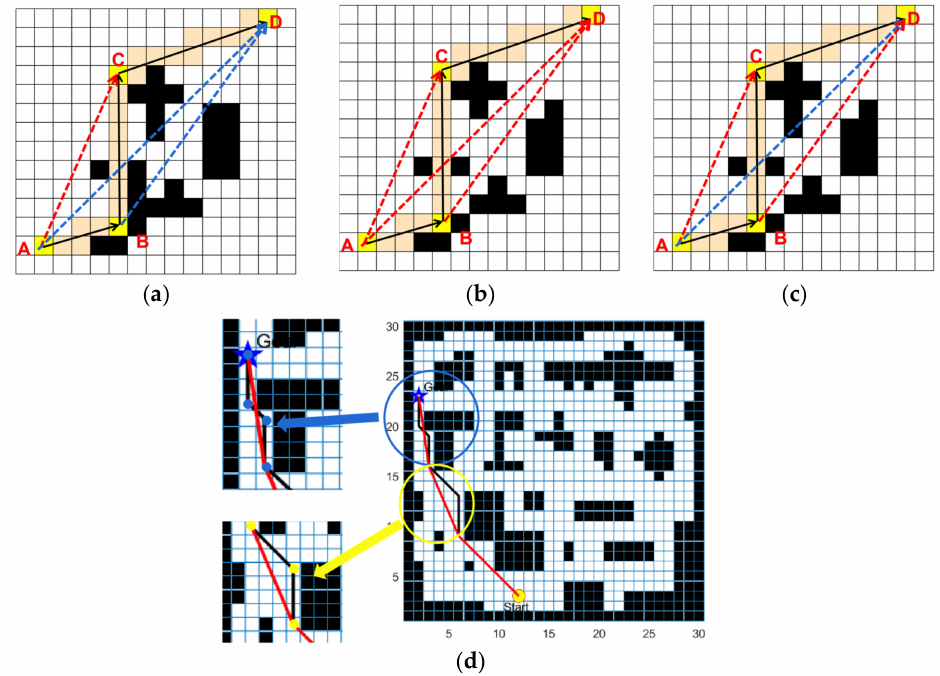
Figure 10. Redundant node removal principle and test: ( a ) No direct path; ( b ) three direct paths; ( c ) no direct path; ( d ) redundant node deletion